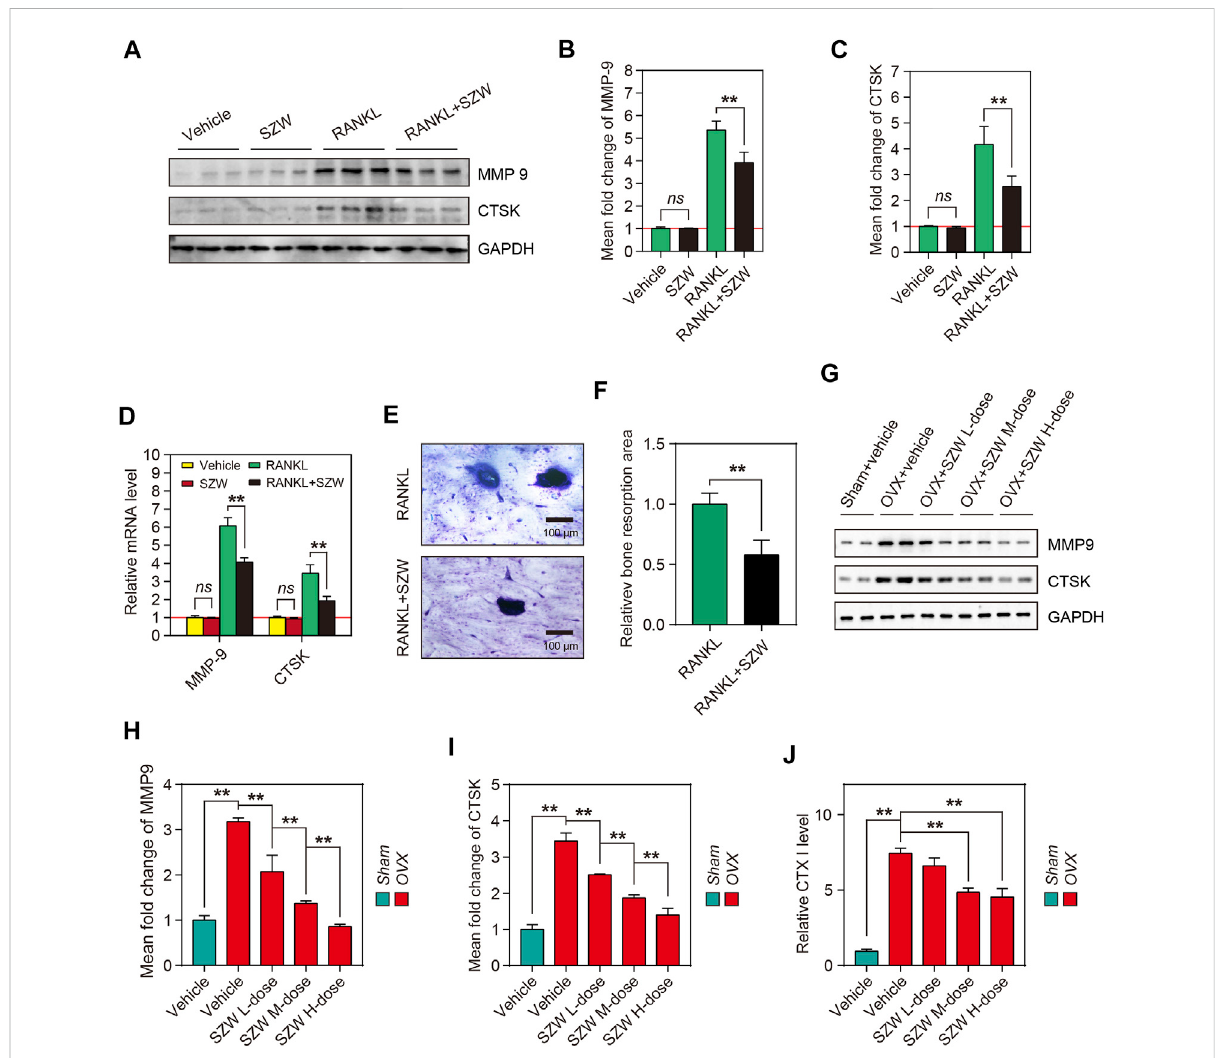
FIGURE 3 SZW attenuated osteoclast-mediated bone resorption. RAW264.7 cells were treated with vehicle (H 2 O) or SZW in the presence or absence of RANKL (A) Representative western blotting images showing MMP9 and CTSK expression in RAW264.7 cells (B – C) The mean fold changes of MMP9 and CTSK expression were quanti fi ed using ImageJ (D) Quantitative real time RT-PCR results showing the expression level of bone erosion- related genes in RAW264.7 cells following vehicle or SZW treatment (E) Representative toluidine blue staining of bovine bone slices for osteoclast resorption (F) Quantitative analysis of bone resorption pits using ImageJ (G) Representative western blotting images showing MMP9 and CTSK expression levels in femur tissue of rats (H – I) The mean fold changes of MMP9 and CTSK expression infemur tissues as determined with using ImageJ. Data are expressed as the mean ± SEM (n = 3) (J) Rat serum CTX I level was measured using an Elisa kit. Data are expressed as the mean ± SEM (n = 6). p p < 0.05, pp p <